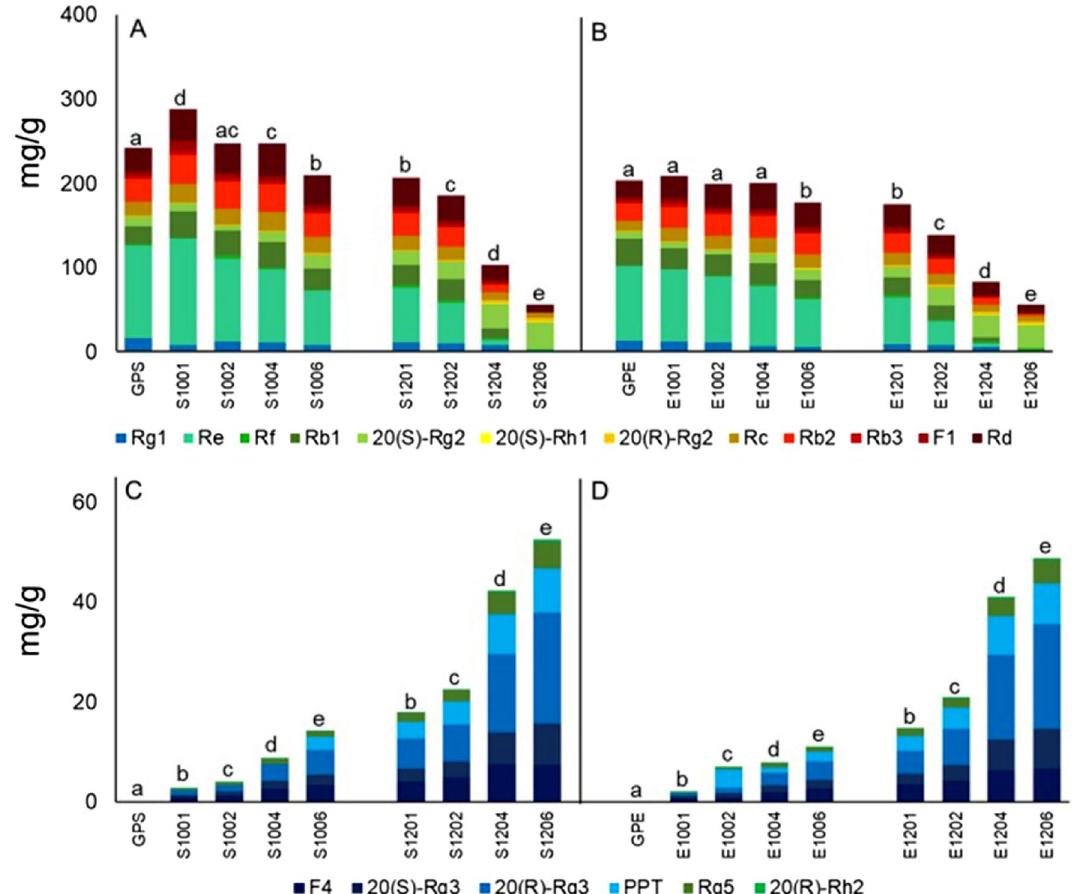
Figure 3. Changes in contents of the 18 ginsenosides in raw and steamed ginseng pulps extracts (GPE) or extracts from ginseng pulp soaking supernatant (GPS). Shown are contents of polar ( A , B ) and less-polar ( C , D ) ginsenosides, as indicated by differently-colored columns, in GPS ( A , C ) and GPE ( B , D ) steamed for 1–6 h at 100 °C (S100 and E100) and 120 °C (S120 and E120). Values marked by different letters at same temperatures are significantly different ( p < 0.05) to those of GPE or